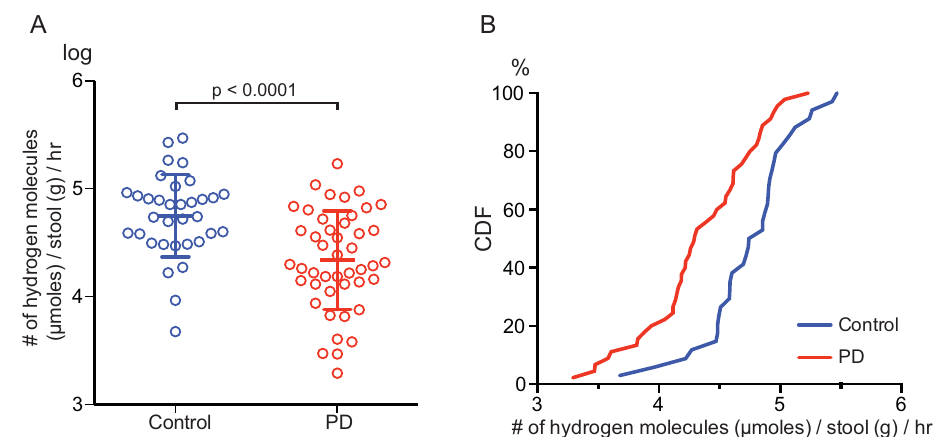
Fig 3. Estimation of the amount of hydrogen production by intestinal microbiota in 45 PD patients and 34 healthy cohabitants that we previously analyzed [11]. The amount of hydrogen production per g stool per hour was calculated using the amounts of hydrogen production by seven bacterial strains measured in this study (Method II). (A) Geometric distribution plot. Bars represent mean and SD. P value was calculated with Student’s t -test. (B) Cumulative distribution function (CDF)